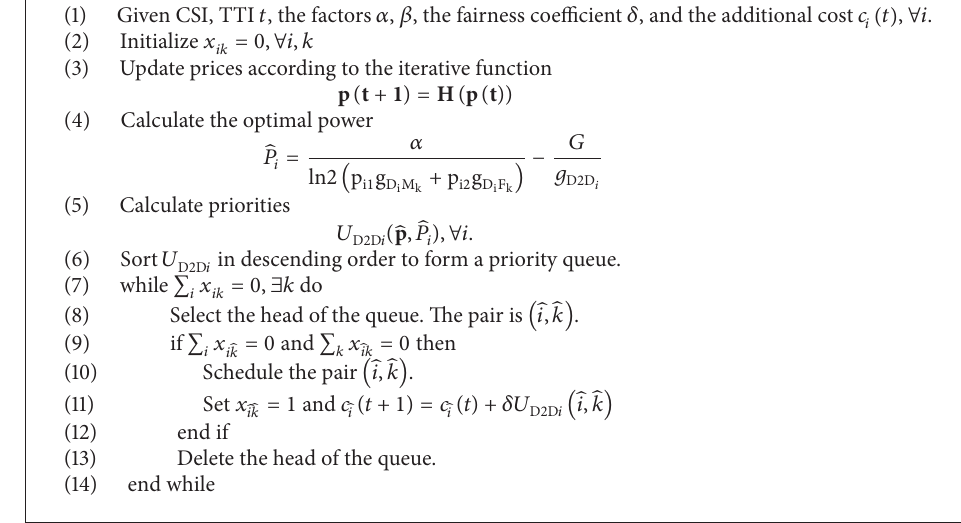
Algorithm 1: Joint D2D scheduling and resource allocation algorithm.